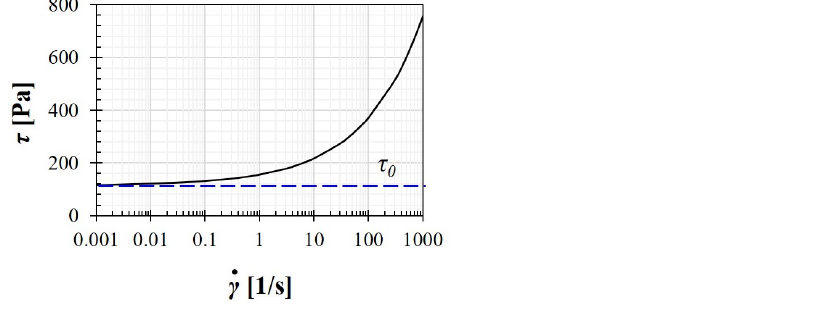
Figure 1. Correlation between the shear stress τ and the deformation rate ˙ γ during the flowing of Carpobol